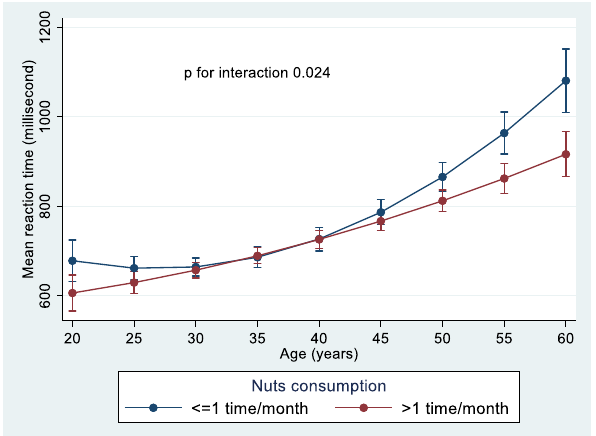
Figure 1. Interaction between nuts intake and age in relation to mean reaction time. Model was adjusted for age, sex, education, and literacy levels, smoking, physical activity level, and BMI.